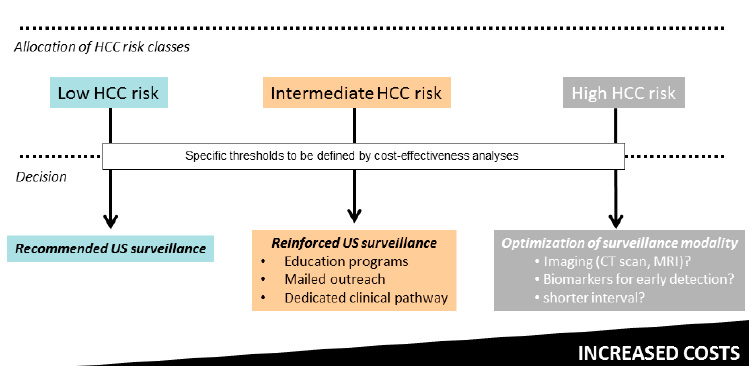
Figure 1. Potential application of hepatocellular carcinoma (HCC) risk stratification using scoring systems: reinforcement of surveillance programs in patients with the highest incidences to optimize screening uptake and efficacy. The optimal thresholds will depend upon the proportion of patients allocated to each class and on cost ‐ effectiveness estimates.